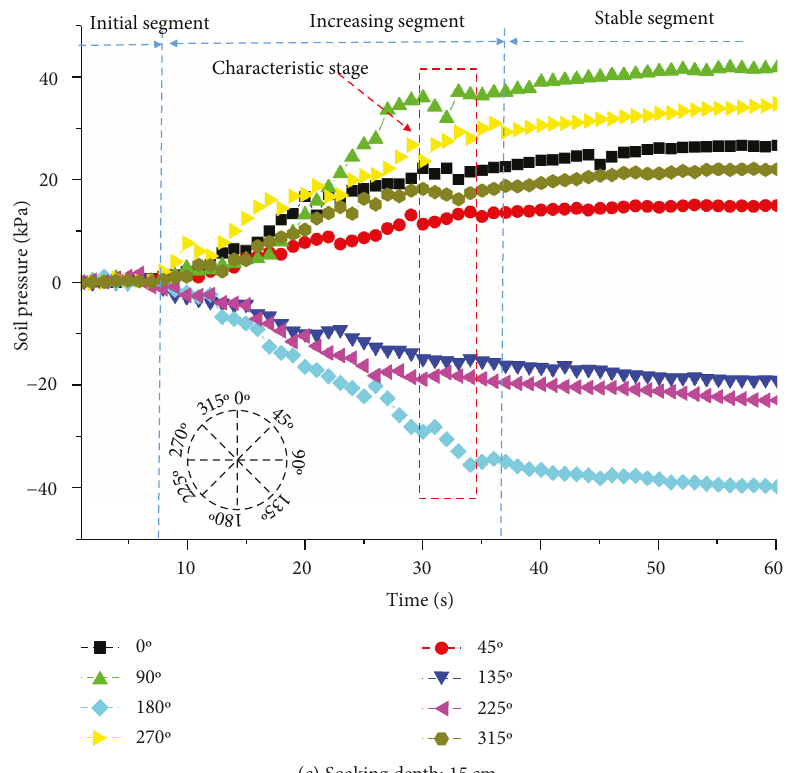
Figure 10: Soil pressure of full-range soaking with operating time.